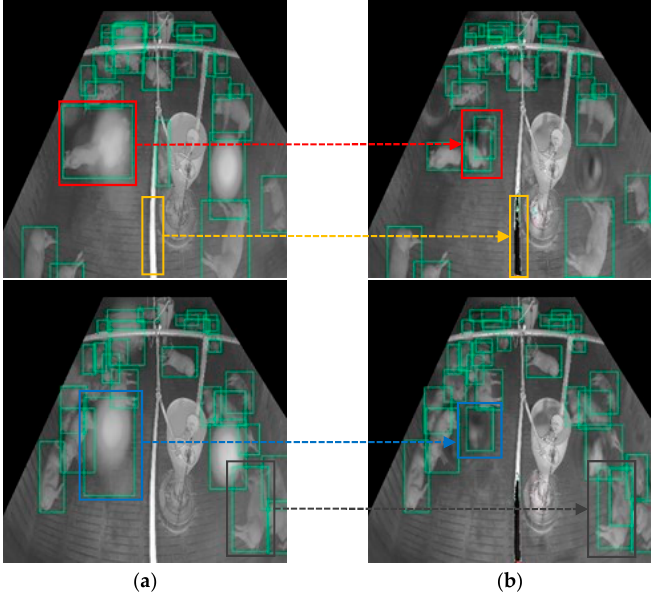
Figure 18. Limitations of the proposed method: ( a ) pig detection results on real-noisy image; ( b ) pig detection results on the denoised image by the proposed model.